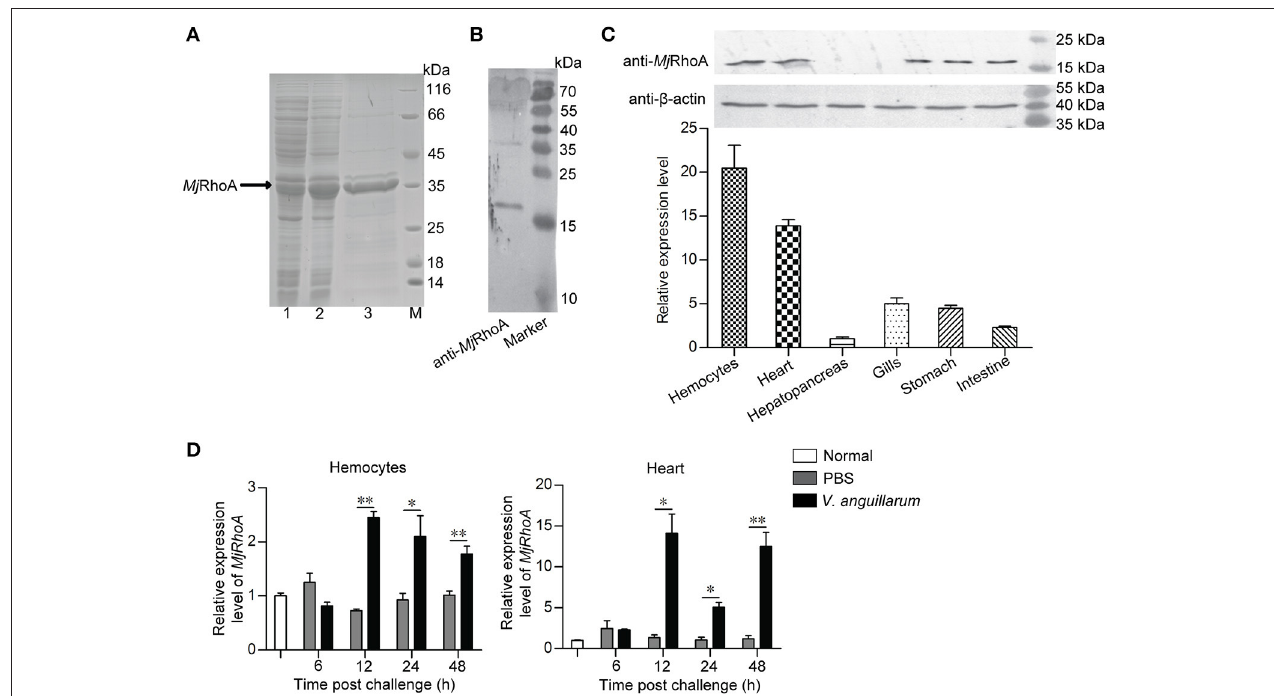
FIGURE 1 | Mj RhoA was upregulated in shrimp challenged by V. anguillarum . (A) Recombinant expression of Mj RhoA in E. coli cells detected by SDS-PAGE. Lane 1, total proteins in the E. coli Rosetta cells transformed with pET30a- MjRhoA before induction with IPTG; Lane 2, total proteins in the E. coli Rosetta cells containing pET30a- MjRhoA after induction with 0.5mM IPTG; Lane 3, purified recombinant Mj RhoA using affinity chromatography with a His-binding resin; Lane M, protein standard. (B) The specificity of the anti- Mj RhoA prepared using the recombinant Mj RhoA was detected by western blotting. (C) Expression level of Mj RhoA in different tissues of normal shrimp. The expression level of Mj RhoA in hemocytes and other five tissues (heart, hepatopancreas, gills, stomach, and intestine) were detected by western blot (upper) and qPCR (bottom). In the qPCR results, the relative expression levels in different tissues were normalized by the lowest expression level of MjRhoA in the hepatopancreas. (D) The expression patterns of MjRhoA at different time points post V. anguillarum challenge. Untreated shrimp and the shrimp injected with PBS were used as controls. All the results were from at least three repeated experiments and are shown as the mean ± SD. The significance of the differences was analyzed using Student’s t -test. * p < 0.05, ** p <